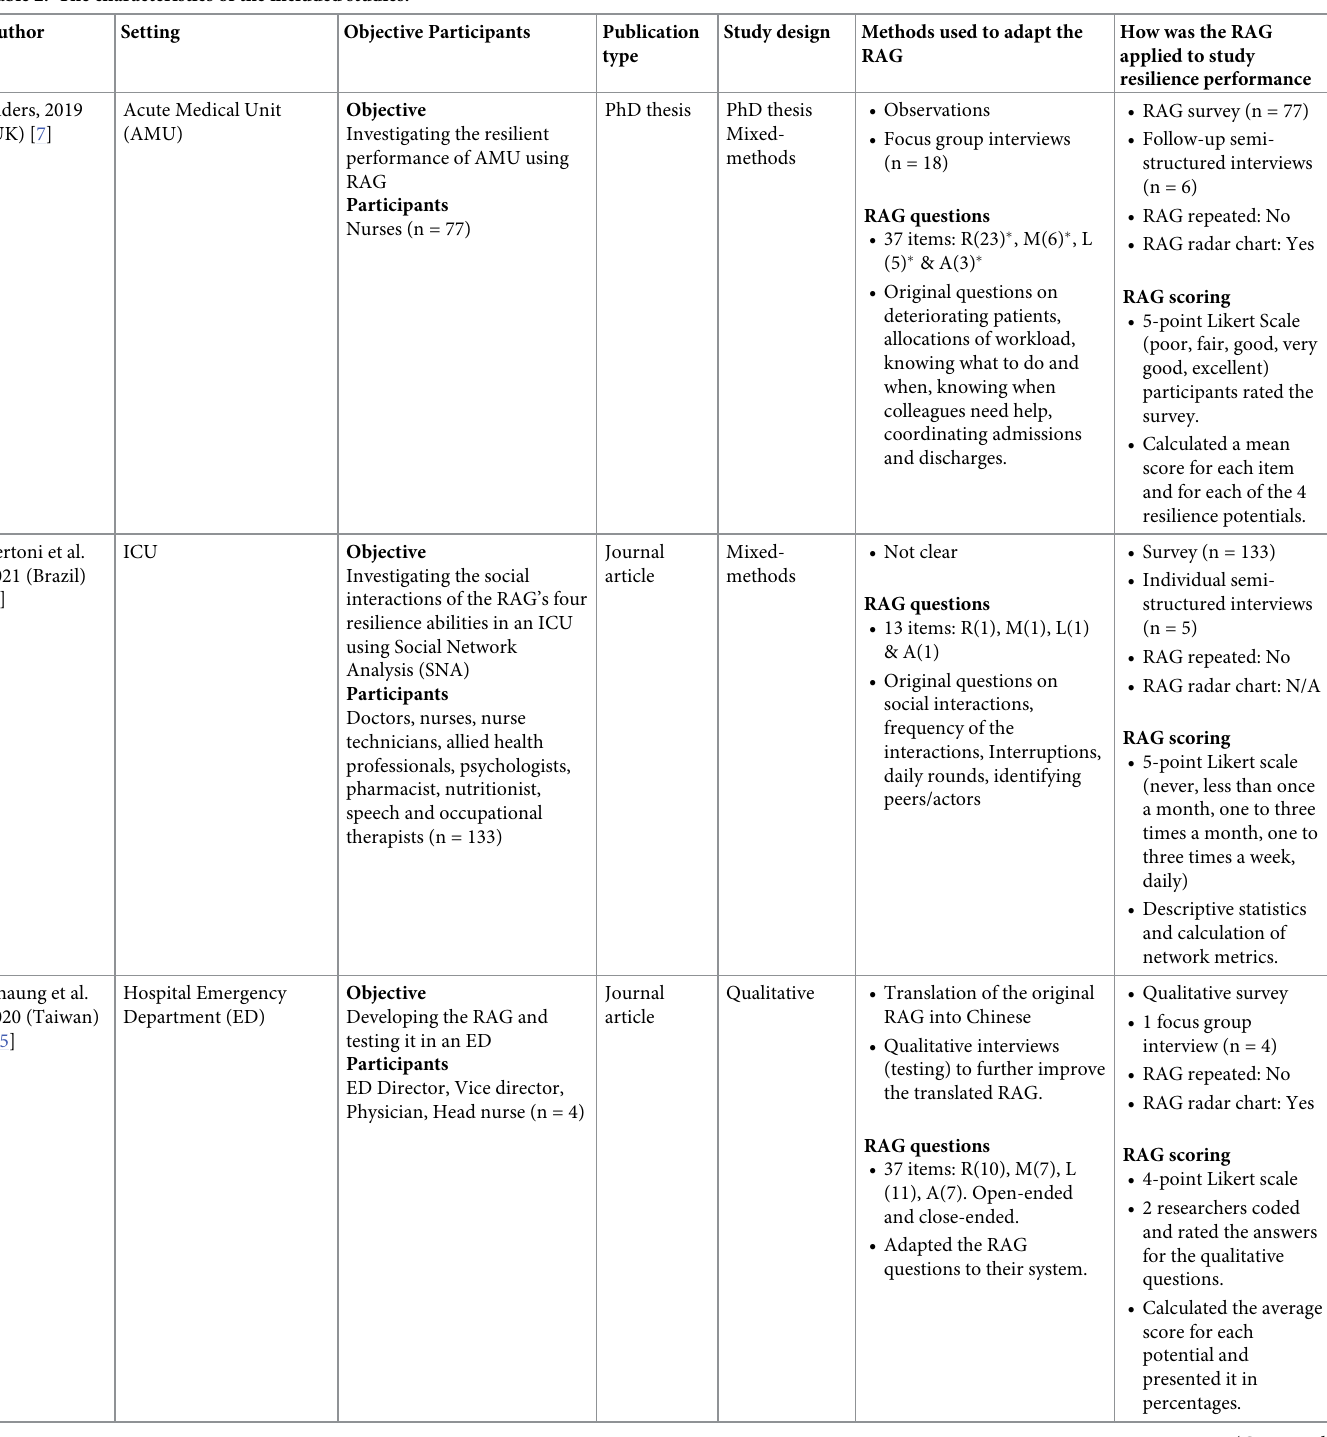
Table 2. The characteristics of the included